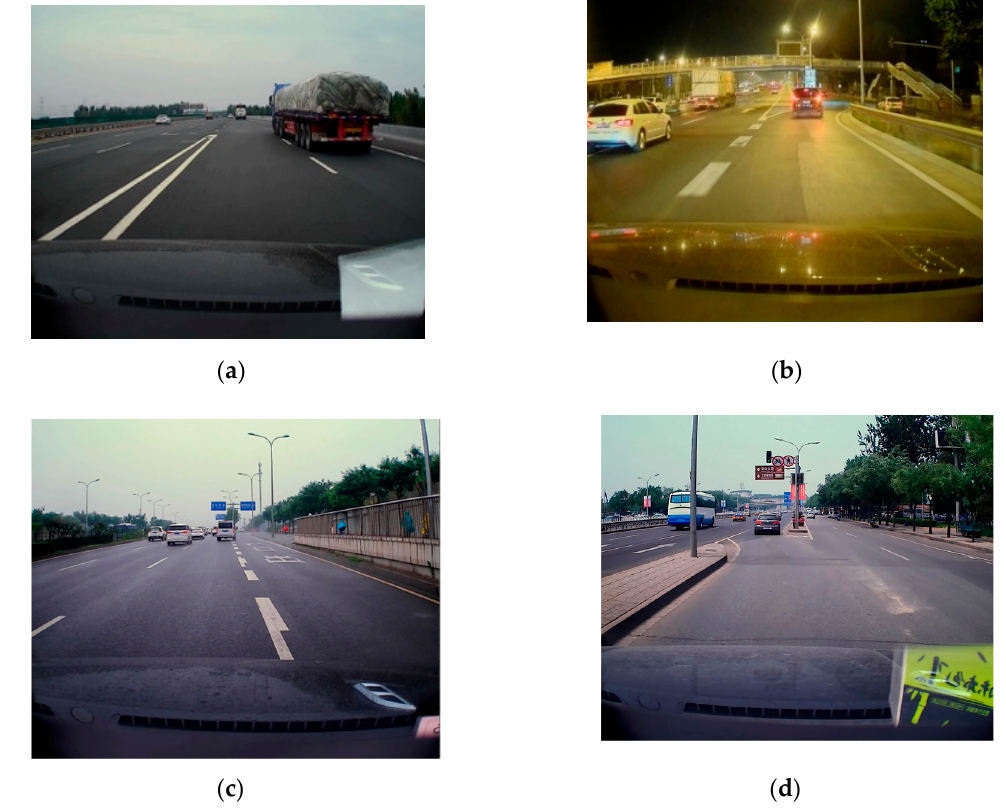
Figure 14. Motion detection for vehicle merging at highway on-ramps ( a ) / o ff -ramps ( c ) and urban on-ramps ( d ) / o ff -ramps ( b ). (2) Turning